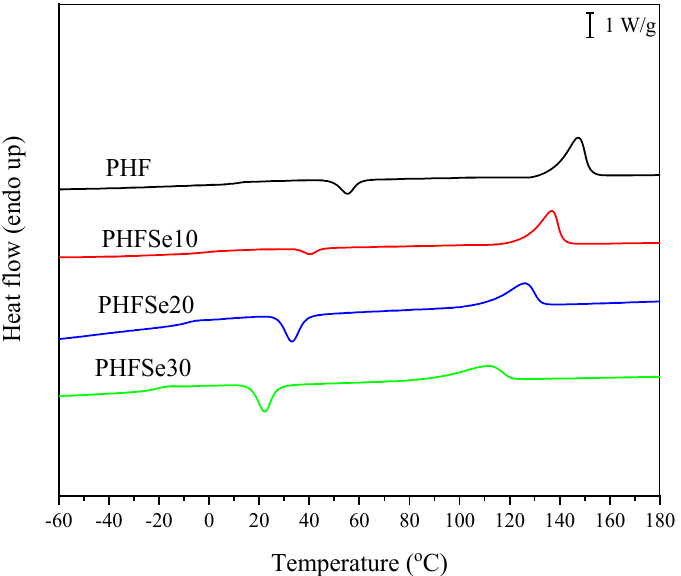
Figure 3. DSC heating curves of PHF and PHFSe copolyesters at 20 °C/min after quenching from molten state.